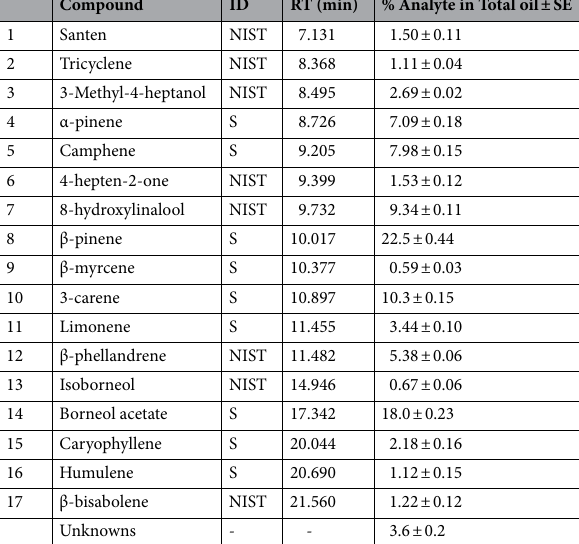
Table 1. Compounds identified in Balsam fir needles by GC–MS. RT= Retention Time, ID= Identification Reference Source, NIST=National Institute of Standard Technology, S=Chemical